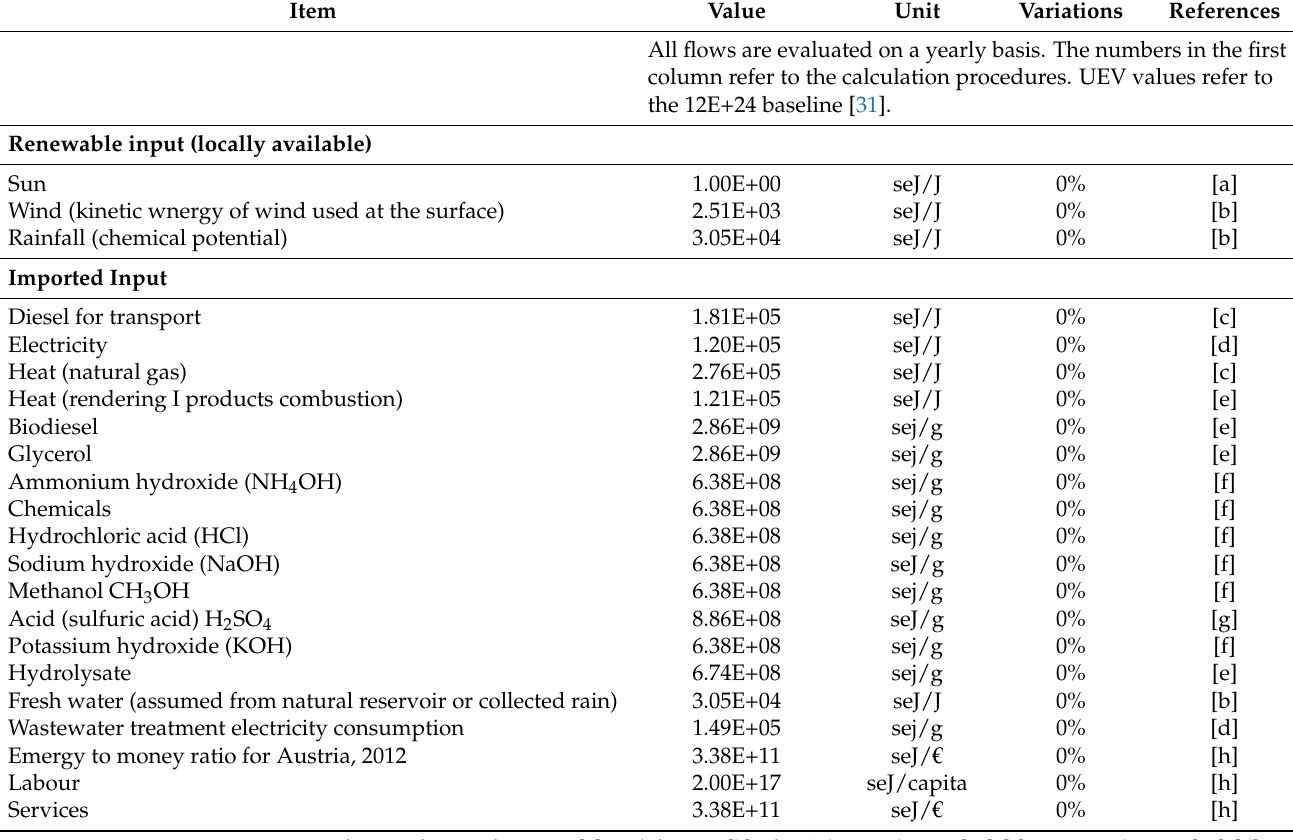
Table 1. Transformities and other Emergy intensities of material and energy flows.